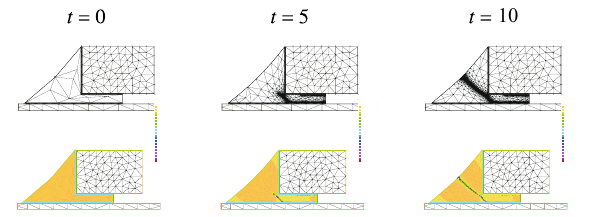
Fig. 14 Snapshots of cracking in solders with a fillet shape. Tempo- ral evolution of meshing (upper) and temporal evolution of z (bot- tom) show crack propagation